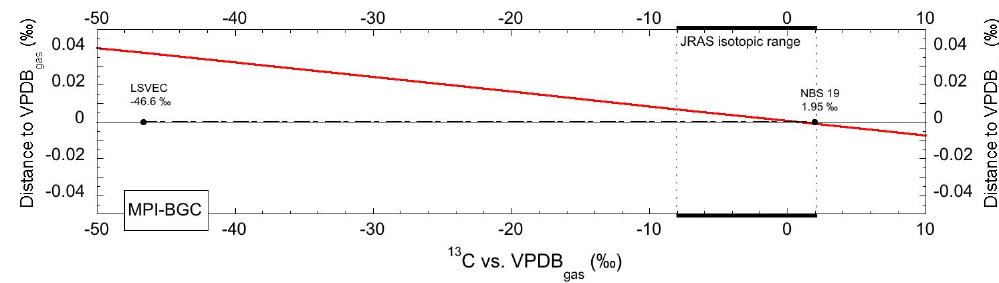
Figure 3. Extrapolation of the MPI-BGC results presented in Figure 2 to the isotopic range Fig. 3. Extrapolation of the MPI-BGC results presented in Fig. 2 to the isotopic range spanned by NBS 19 and LSVEC. spanned by NBS 19 and LSVEC.